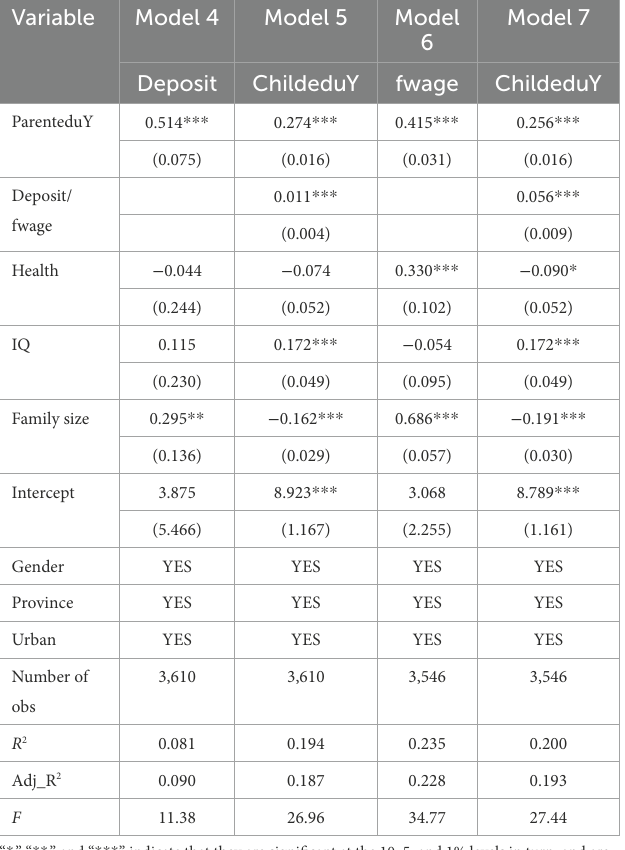
TABLE 6 Results of the mediating effects model after replacing the main